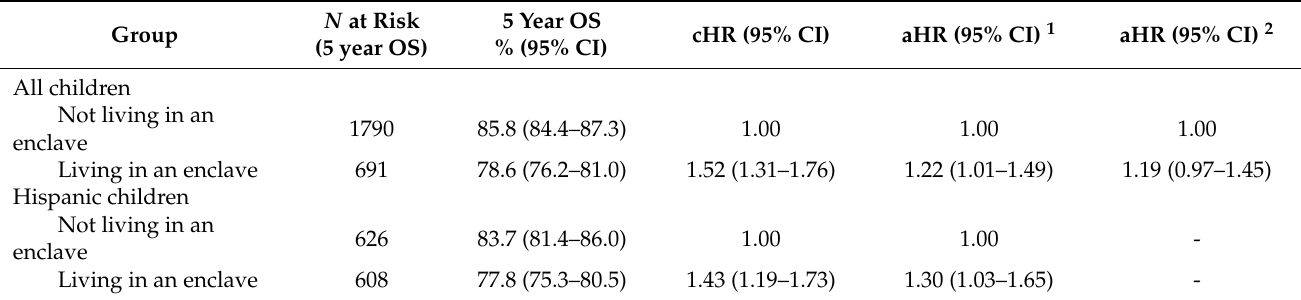
Figure 2. Kaplan–Meier analysis indicates children living in Hispanic enclaves have poorer overall survival. Significant survival disparities were observed for children in Hispanic enclaves at the time of their diagnosis (red), relative to children not in enclaves (blue). Table 2. Estimated 5-year overall survival and hazard of death for children living in Hispanic enclaves.